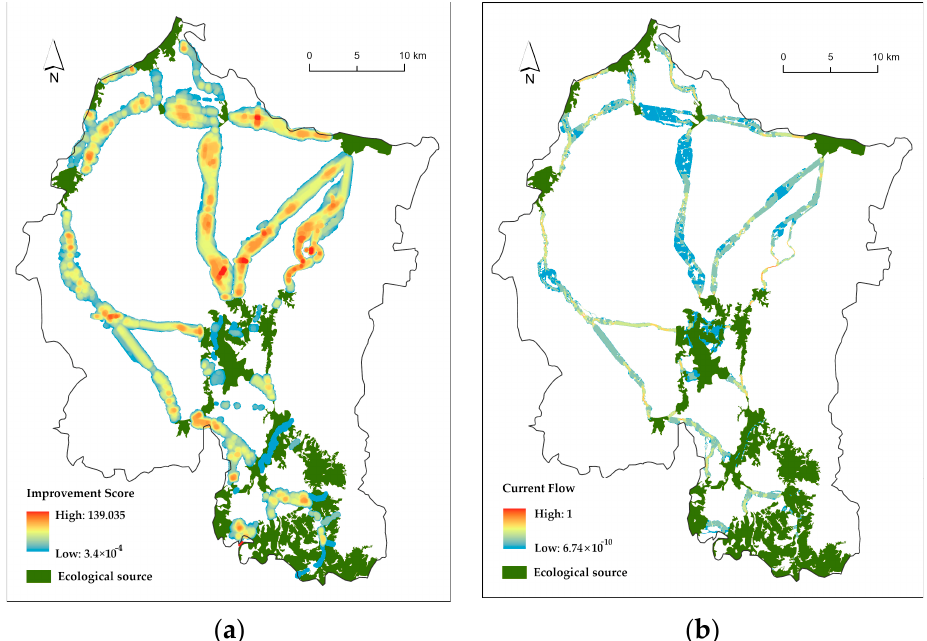
Figure 13. Analyses of ecological nodes. ( a ) Analysis of ecological barrier points; ( b ) analysis of ecological pinch points.